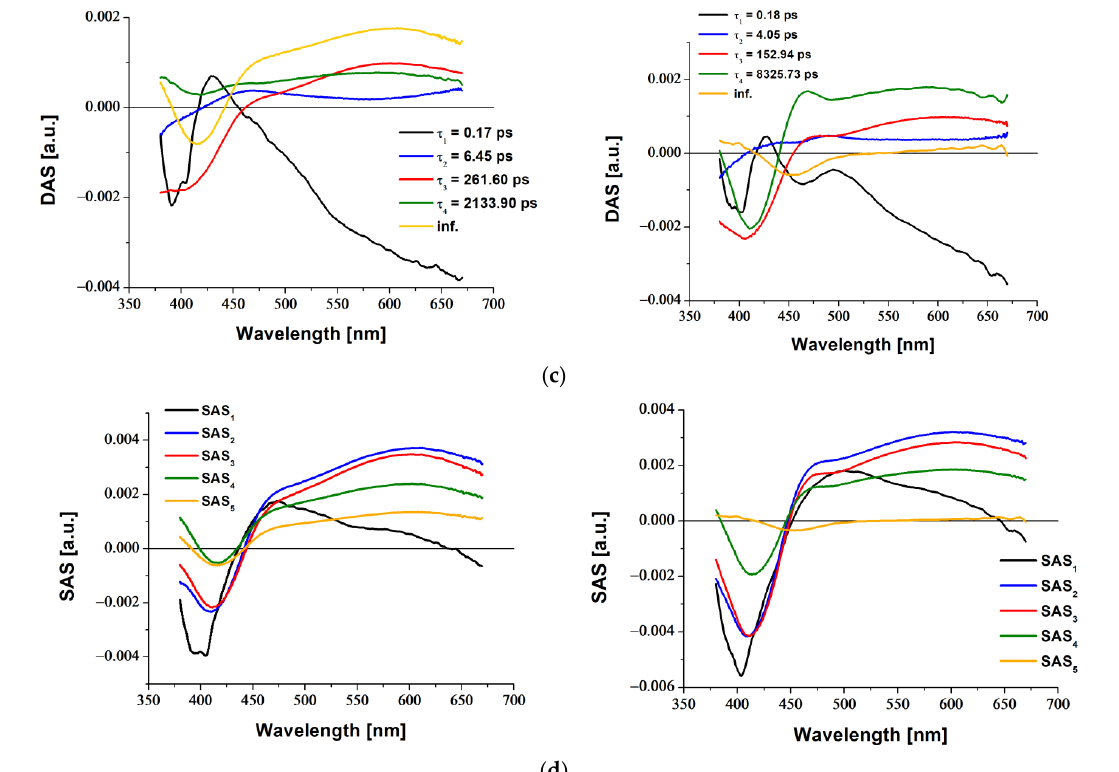
Figure 10. The fsTA 2D maps ( a ) and TA spectra at selected time delays ( b ), decay associated spectra (DAS i ) ( c ), and species associated spectra (SAS i ) ( d ) for complexes 1 and 2 in chloroform.